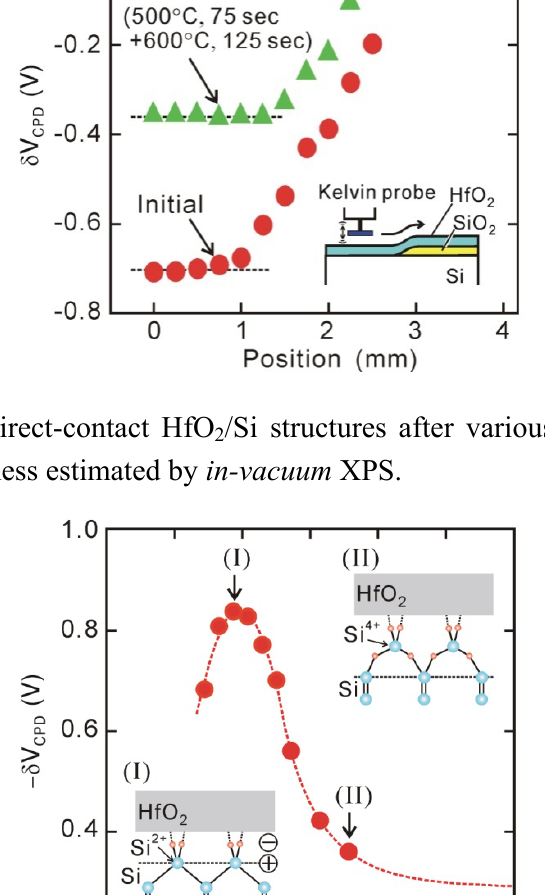
/Si and HfO /SiO /Si stack 2 2 2